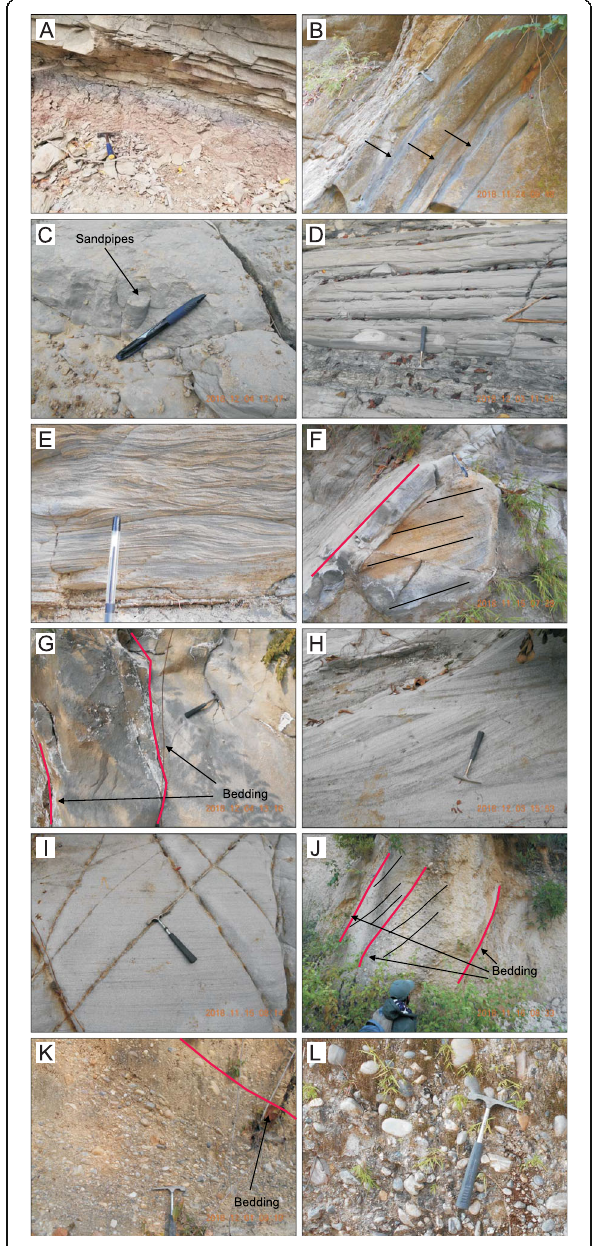
Fig. 2 Representative outcrop photographs of the 12 lithofacies. A Reddish-brown mudstone (facies P) from FA1, B peaty mudstone (facies C) from FA1, C massive mudstone (facies Fm) with sandpipes from FA1, D mudstone to very fine – grained sandstone with parallel lamination (facies Fl) from FA1, E fine-grained sandstone with ripple cross-lamination (facies Sr) from FA2, F medium-grained sandstone with planer cross-stratification (facies Sp) from FA3, G massive (facies Sm) sandstone from FA3, H sandstone with trough cross-stratification (facies St) from FA4, I sandstone with horizontal lamination (facies Sh) from FA4, J conglomerate showing weak planer cross-stratification (facies Gp) from FA5, K matrix-supported gravelly conglomerate with inverse grading (facies Gmg) from FA5, L matrix-supported poorly sorted pebble to cobble size massive conglomerate (facies Gmm) from